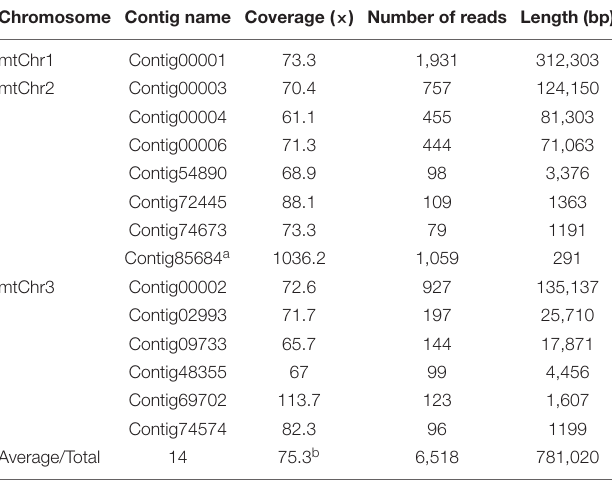
TABLE 1 | Newbler assembled contigs of P. simonii